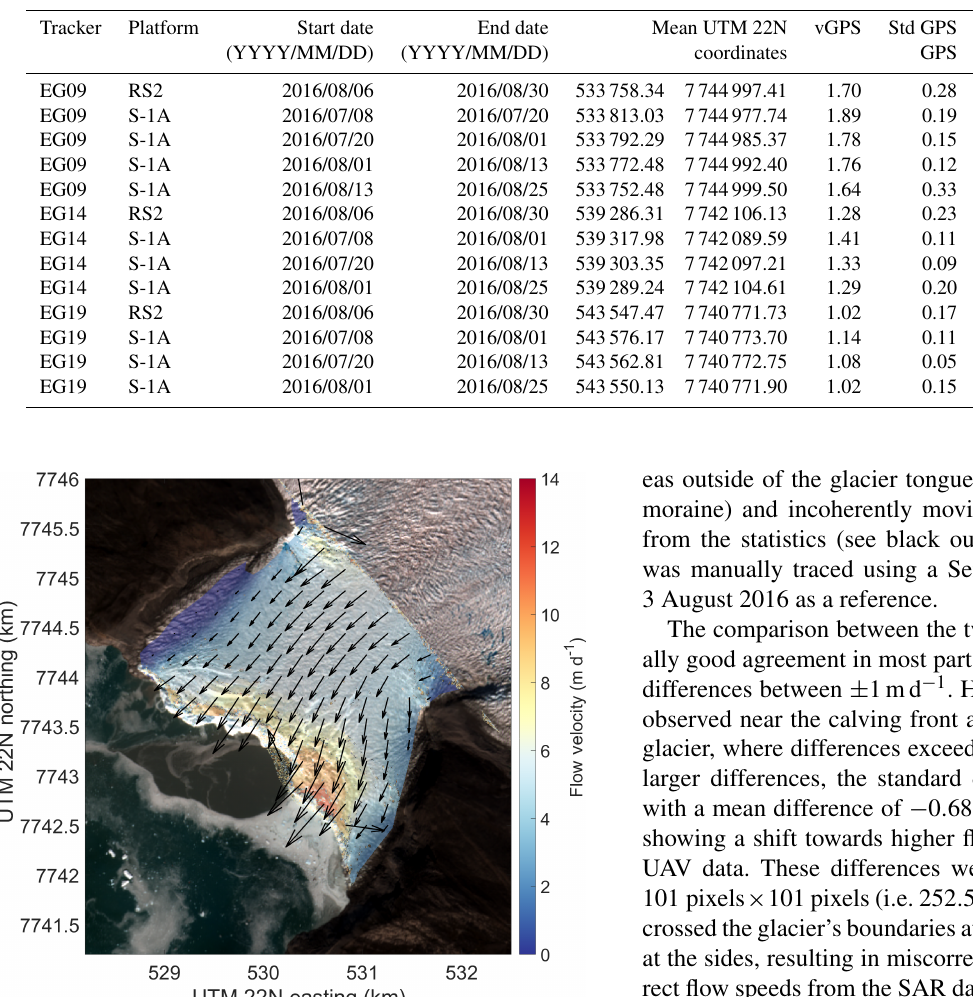
Table 4. Comparison of flow velocities derived by intensity tracking from Sentinel-1 or RADARSAT-2 radar imagery and from GPS mea- surements. Ice velocities are given in metres per day (md − 1 ), and UTM 22N coordinates are given in metres (m).